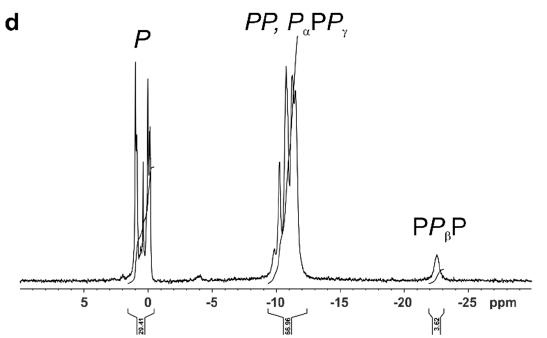
Figure 6. NMR analysis of the OS HOAc preparation of Pst DC3000 Δ wbpL LPS. ( a ) Shown above is the full 1 H NMR spectrum ( δ H 6.0–0.5; recorded in D 2 O at 300 K); regions for signals resulting from N-/O-acetyl groups, Ala-CH 3 , and Rha-CH 3 , respectively, are indicated. ( b , c ) Sections of the 1 H, 13 C-HSQC NMR spectrum showing regions with 1 H, 13 C-cross correlations for N-/O-acetyl groups ( δ H 2.40–1.80; δ C 25–19; ( b )) as well as Ala-CH 3 and Rha-CH 3 moieties ( δ H 1.90–0.80; δ C 20–15; ( c )) are shown. The signal assignment is discussed in the text. ( d ) Shown above is the 31 P NMR spectrum ( δ P 10-(-30)) recorded in D 2 O at 300 K. Monophosphates ( P ) are represented by the group of signals between δ P 2 and − 1 ppm, diphosphates ( PP ) as well as P α and P γ of triphosphates appear between δ P − 9 and − 12 ppm, and P β of triphosphates is represented by the broad signal between δ P − 22 and − 23 ppm.